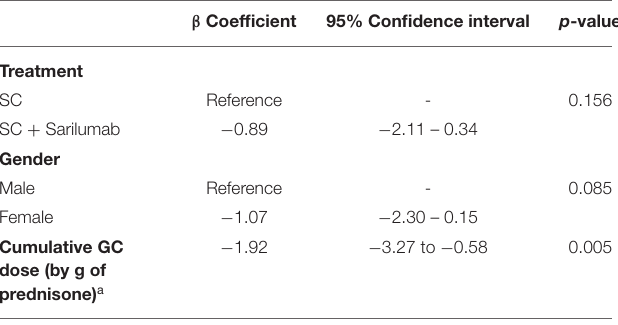
TABLE 4 | Variables associated with improvement in clinical status at day 7.